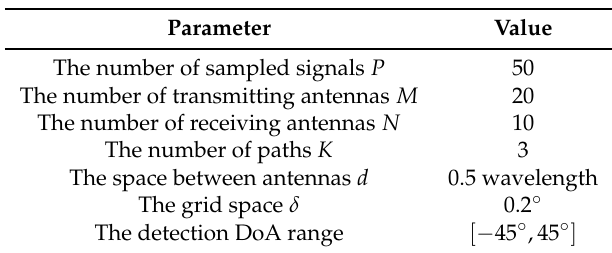
Table 1. Simulation Parameters.